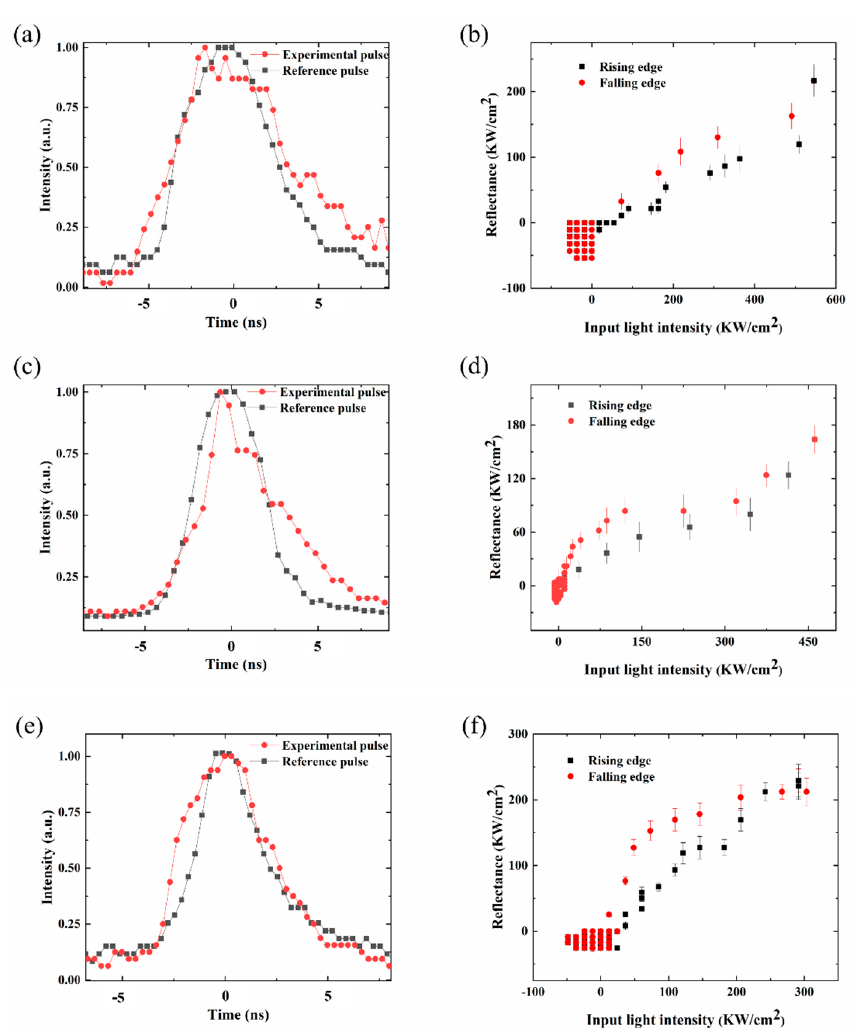
Figure 5. ( a , c , e ) The two waveforms displayed on the high-speed numerical oscilloscope. ( b , d , f ) The hysteresis loops of the optical bistability realized by converting the electrical signal into the opti- cal signal, low-threshold visible light optical bistability with light intensity of 267 KW/cm 2 can be